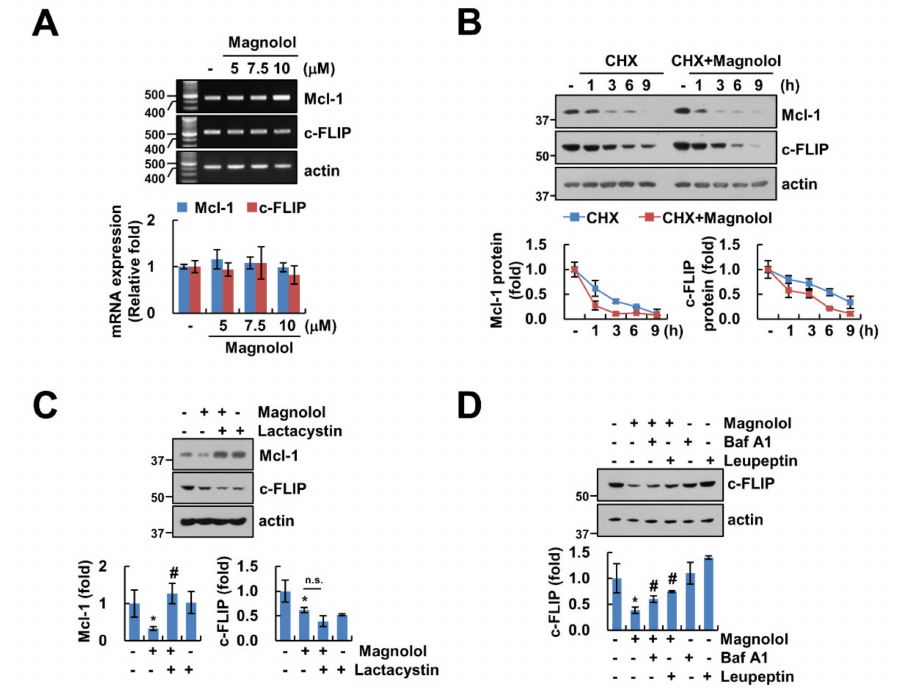
Figure 5. Magnolol induced downregulation of Mcl-1 and c-FLIP proteins at the